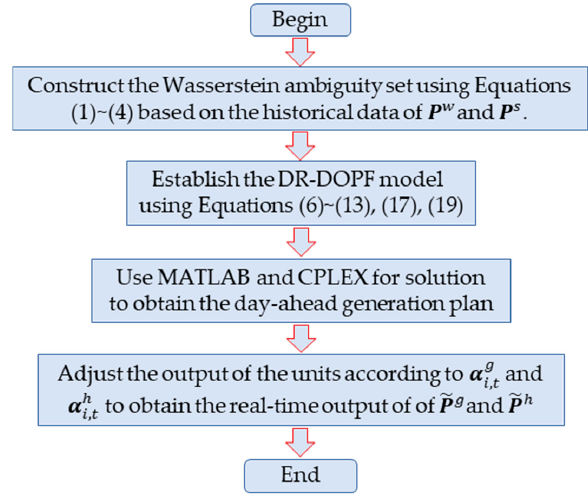
Figure 2. Flowchart of DR-DOPF model.